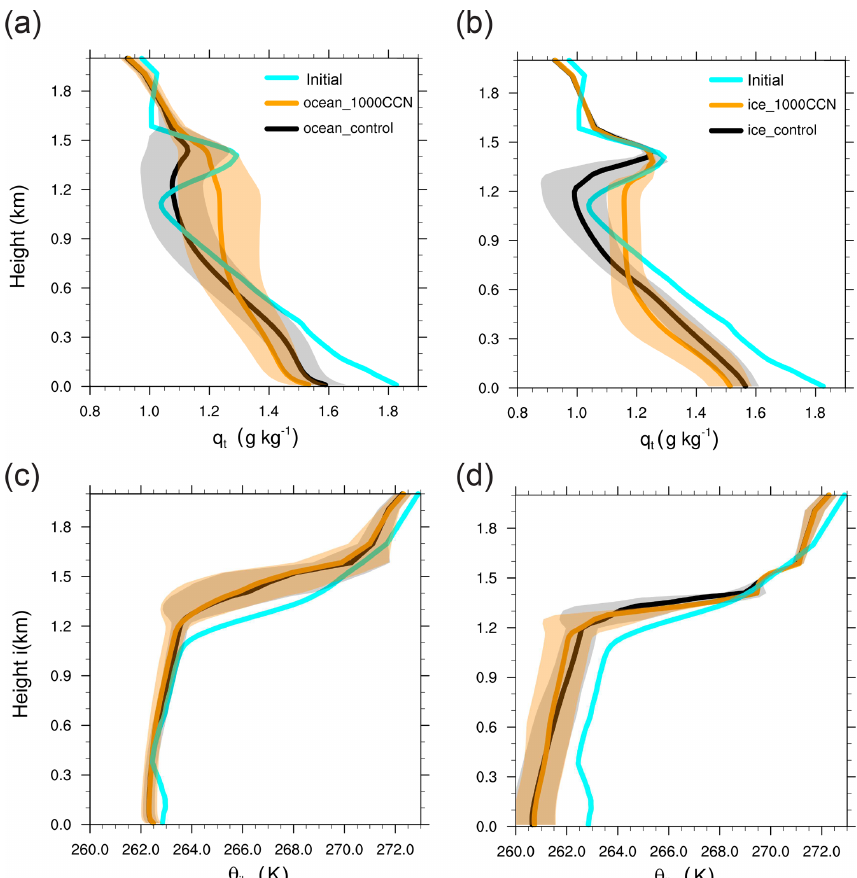
Figure 1. Time- and domain-averaged ( ± 1 standard deviation) (a) total water content q t ( q t = q c + q v + q i ) in the ocean_control simulations as well as most perturbed ocean_1000CCN simulation, (b) total water content q t in the ice_control and ice_1000CCN simulations, (c) ice- liquid potential temperature ( θ il ) in the ocean_control and ocean_1000CCN simulation, and (d) θ il in the ice_control and ice_1000CCN simulation (for an overview of the simulations refer to Table 1). The blue lines represent the modeled initial values (i.e., time step